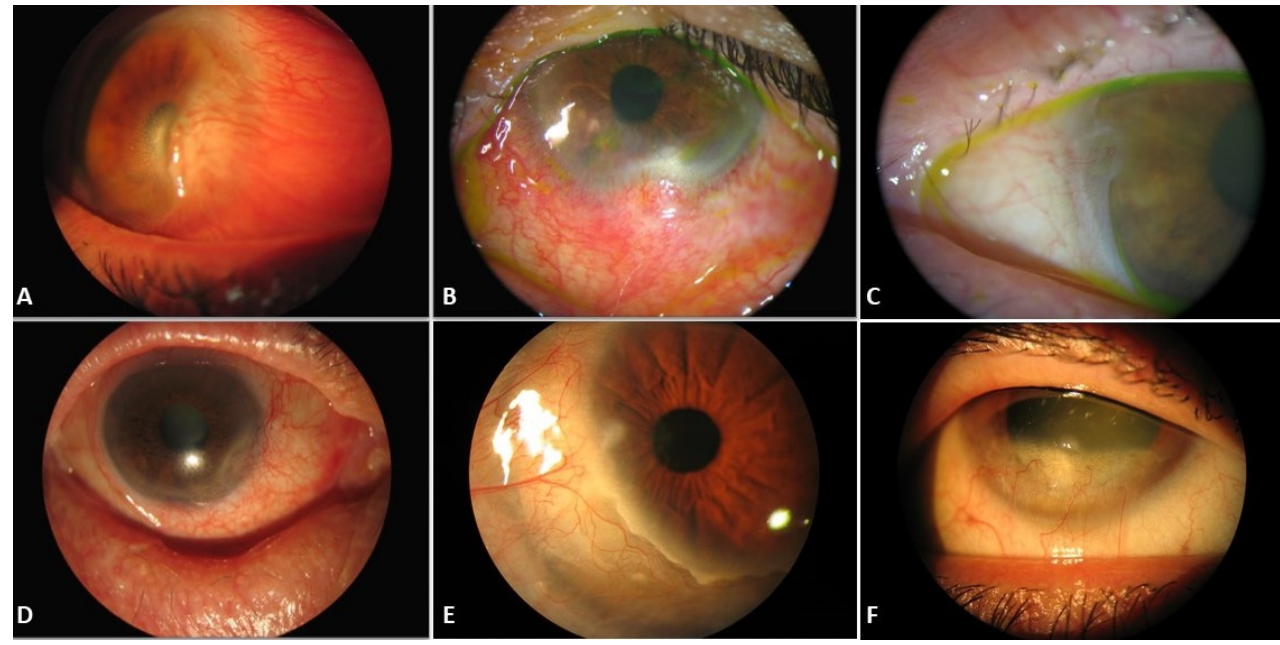
Figure 2. Slit-lamp images of pseudopterygium in different pathologies: ( A ) Corneal burn. ( B ) Ex- cisional biopsy of conjunctival nevus. ( C , D ) Mucous membrane pemphigoid. ( E , F ) Terrien’s marginal